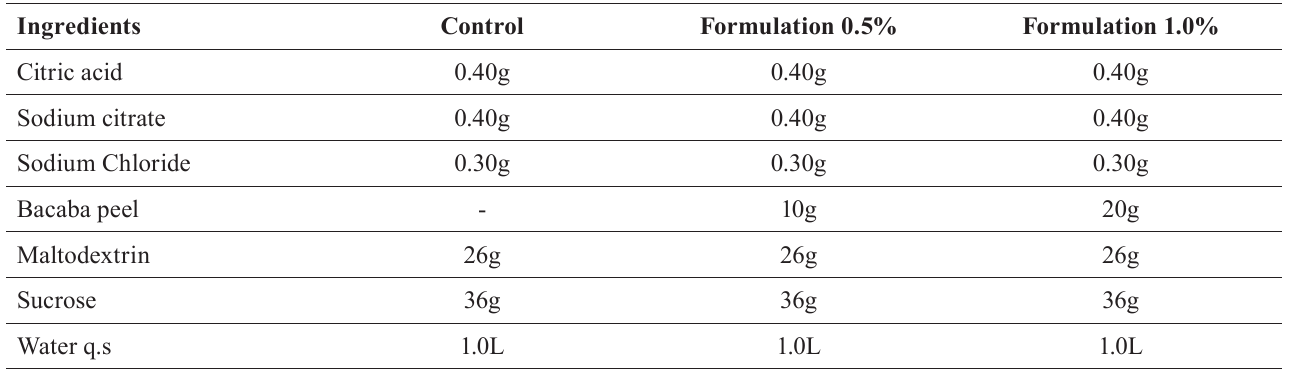
TABLE I - I ngredients used in the preparation of the hydroelectrolytic beverage formulations containing 0.5 % and 1.0 % of bacaba peel extract and control